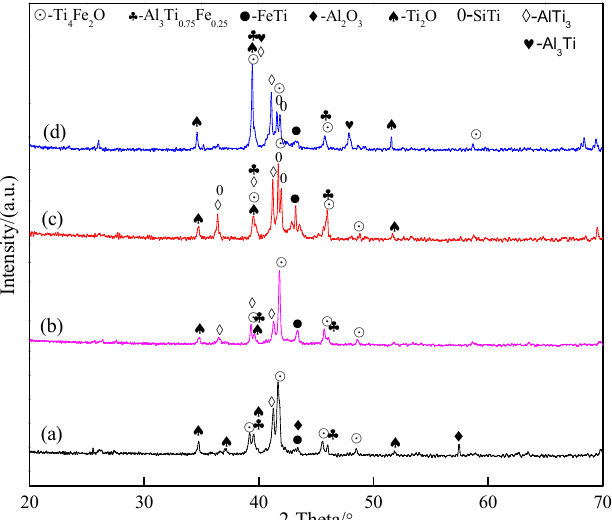
Figure 3. X-ray diffraction patterns of ferrotitanium produced from ilmenites with different reduction degrees. ( a ) 0%, ( b ) 11%, ( c ) 43%, and ( d ) 75%.